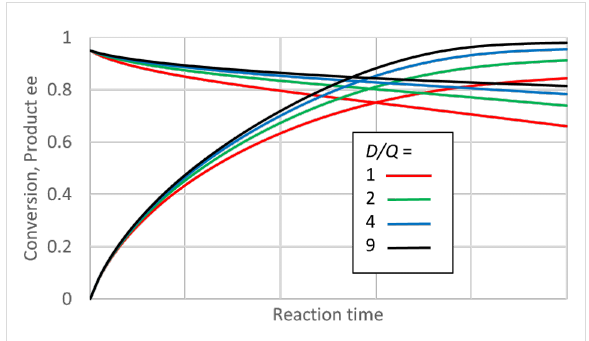
Figure 1: Reaction progress for “ordered, second” kinetics and the effect of D / Q (e.g., NADH/NAD + ) ratio. S 0 = 0.2 M, total D + Q = 0.01 M, K eq = 5, E = 39, K MD = 0.001 M, K MS = 0.001 M, k 4 = 1000 s − 1 , SCRf / b = 1, k 3R / k 4 = 1, k 3R / (E · k 3S ) = 1, k − 4 / k 1 = 1, k − 2R / k − 1 = 1, E · k − 2S / k − 1 = 1. For the calculation the enzyme concen- tration was adjusted such that all initial rates were the same.